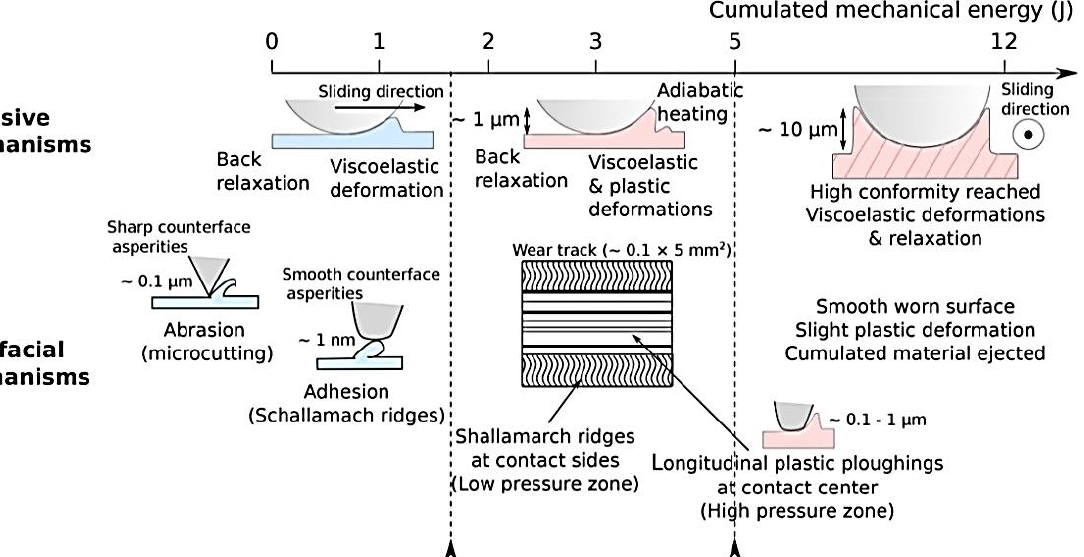
Figure 6. The OFM lubrication mechanism in the PEEK-steel contacts. Figure is reproduced with permission from reference [29].